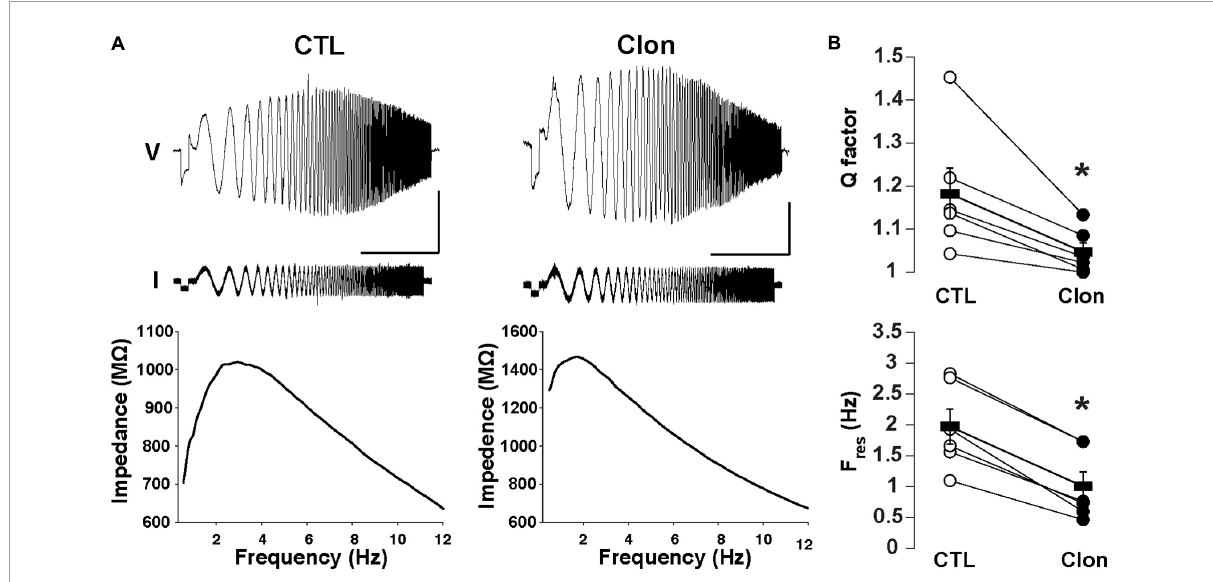
FIGURE4 Activation of α 2 -ARs decreases the resonance of GCs. (A) Top: Voltage responses (upper traces) to a ZAP current stimulus (lower traces) in a GC before (left) and after the application of Clon (10 µ M, right). The calibration is 5 mV and 10 s; the ZAP stimulus amplitude is 5 pA (peak-to-peak). Bottom: impedance profiles for the trials shown in the figure above. In the control condition, the resonant strength (Q factor) is 1.45 and the peak frequency 2.83 Hz. In the presence of Clon (right), the resonant strength is 1.13 and the peak frequency is 1.73 Hz (right). The Vm was maintained at –75 mV for both trials. (B) Summary plots for the effect of Clon. Activation of α 2 -ARs by the agonist significantly reduced both Q factor and resonant frequency (F res ) in GCs. * p <